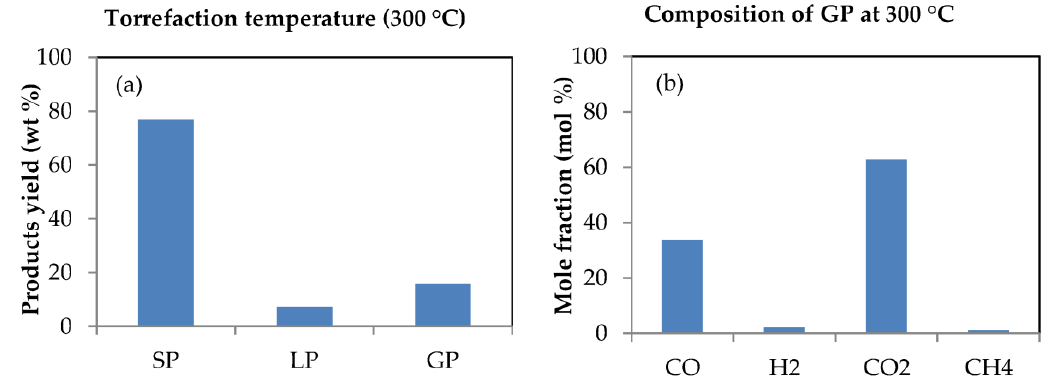
Figure 3. Products obtained from bagasse torrefaction: ( a ) Product yield with SP, LP and GP representing the solid, liquid and gaseous products, respectively; ( b ) composition of gaseous products formed from sugarcane bagasse torrefaction at 300 °C, and at 5 min time of residence.